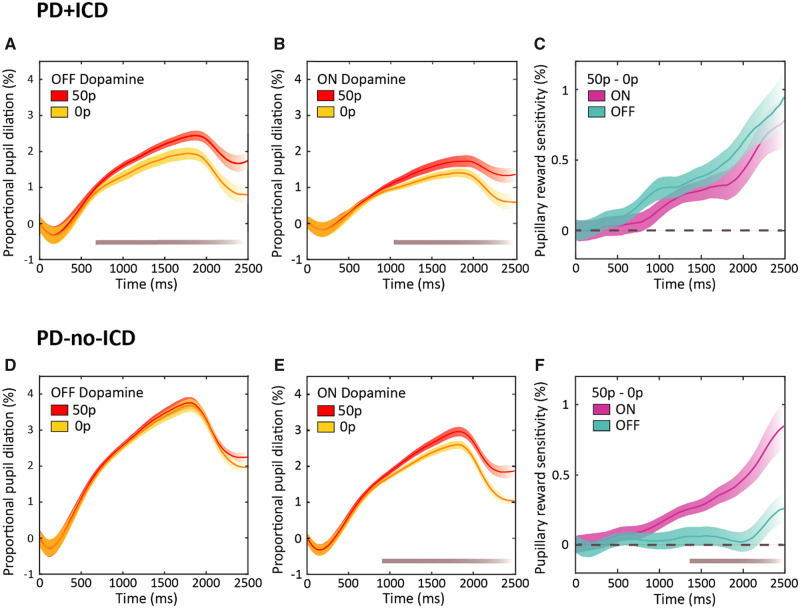

Dynamics of pupil response on low and high reward trials. (A) Mean pupillary trace in PD+ICD OFF dopaminergic medication following onset of auditory reward cue at 0 ms until trial end at 2500 ms. Pupil dilation was calculated as the proportional change from mean baseline before onset of the stimuli. A significant difference between pupil dilation in response to the 50p reward (red) and 0p reward cue (yellow) present from ∼630 ms (P < 0.05), depicted by the grey bar at the bottom of the plot. (B) Mean pupillary trace in PD+ICD ON dopaminergic medication. A significant difference between the 50p reward and 0p reward cue present from ∼1020 ms (P < 0.05) only. (C) Mean pupil dilation reward sensitivity, calculated as proportional pupil change in response to the 50p reward cue minus change to the 0p condition, in PD+ICD ON (turquoise) and OFF (purple) dopamine. No significant difference was found between reward sensitivity ON and OFF at any time point. (D) Mean pupillary trace in PD-no-ICD OFF dopaminergic medication. No significant difference was found between 50p and 0p at any time point. (E) Mean pupillary trace in PD-no-ICD ON dopaminergic medication. A significant difference between the 50p reward and 0p reward cue present from ∼890 ms (P < 0.05). (F) Mean pupil dilation reward sensitivity, in PD-no-ICD ON and OFF dopamine. A significant difference between reward sensitivity ON and OFF dopamine present from ∼1420 ms (P < 0.05). Shaded area represents standard error across subjects after subtracting the mean.